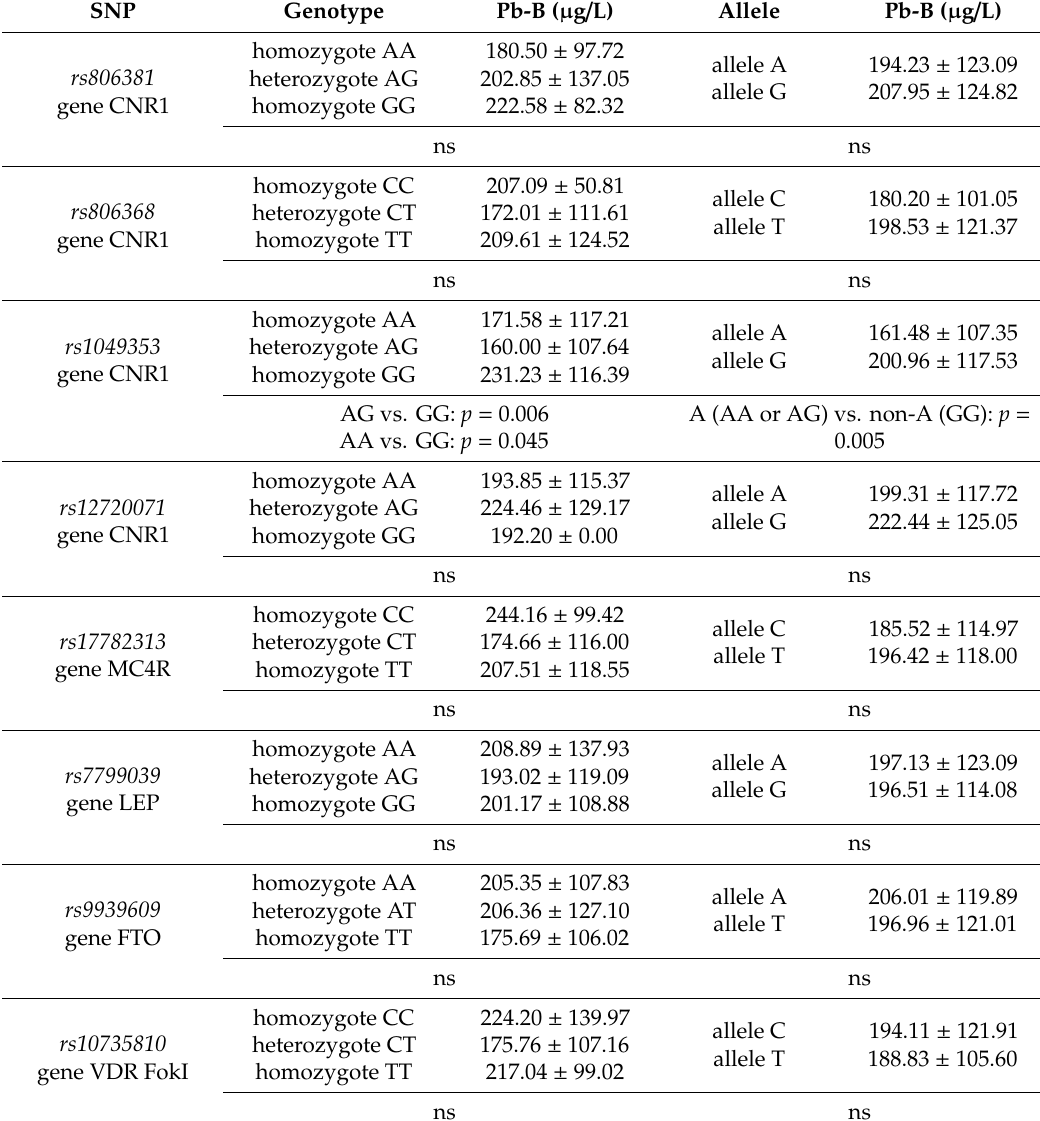
Table 7. Lead concentration in subgroups divided according to selected polymorphisms of genes CNR1, MC4R, LEP, FTO and VDR